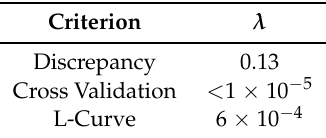
Table 1. λ obtained from three different optimum criteria for the RC-ZARC-element as shown in Figure